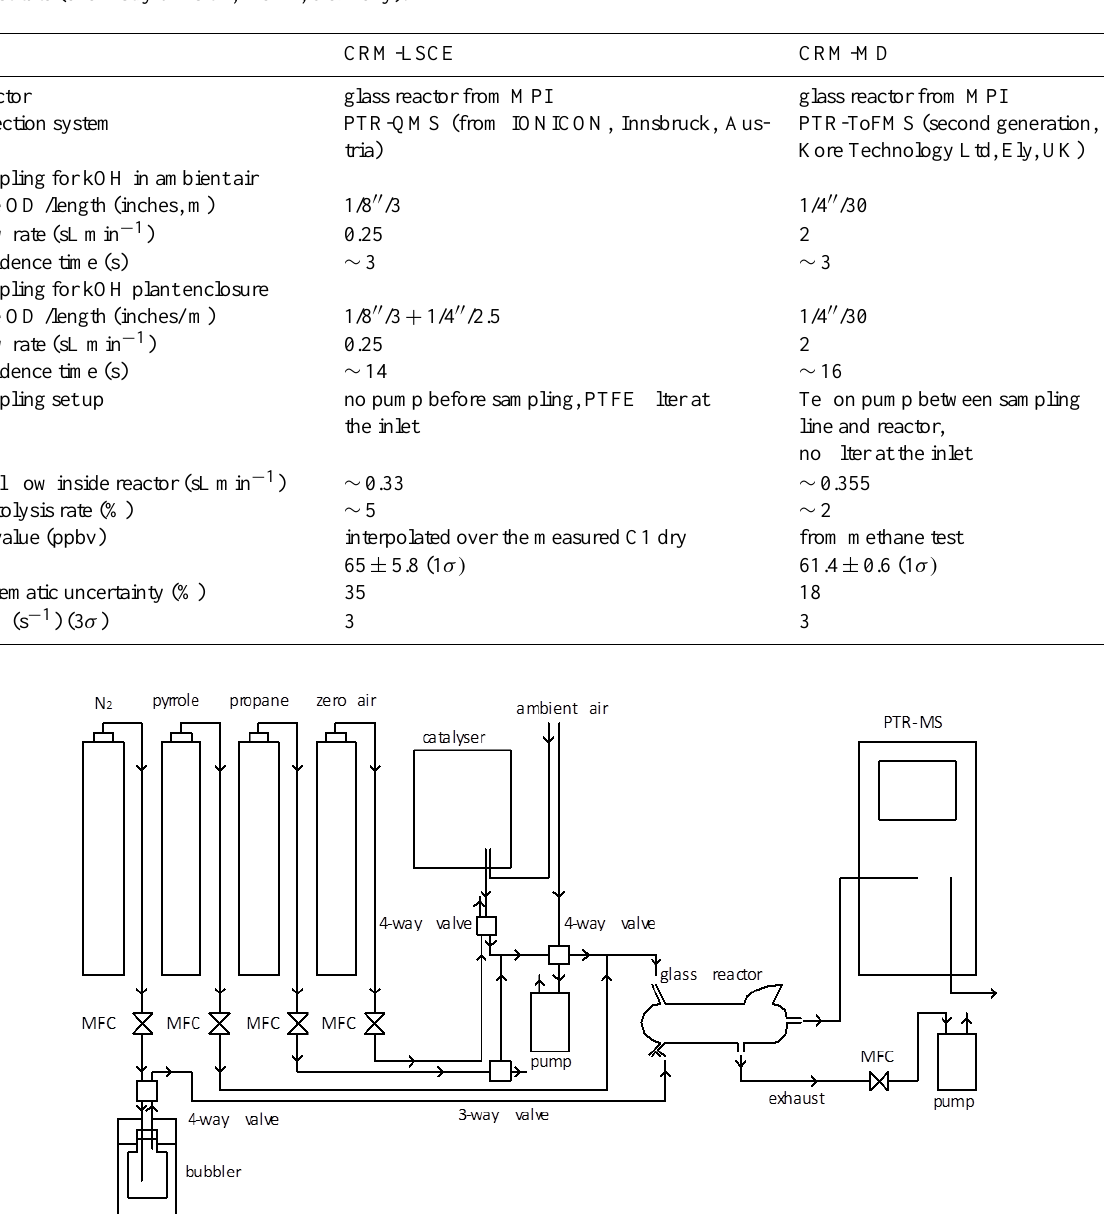
Table 1. Technical parts and operational settings of CRM LSCE and CRM MD during the intercomparison excercise. MPI stands for Max Planck Institute (chemistry division, Mainz, Germany).